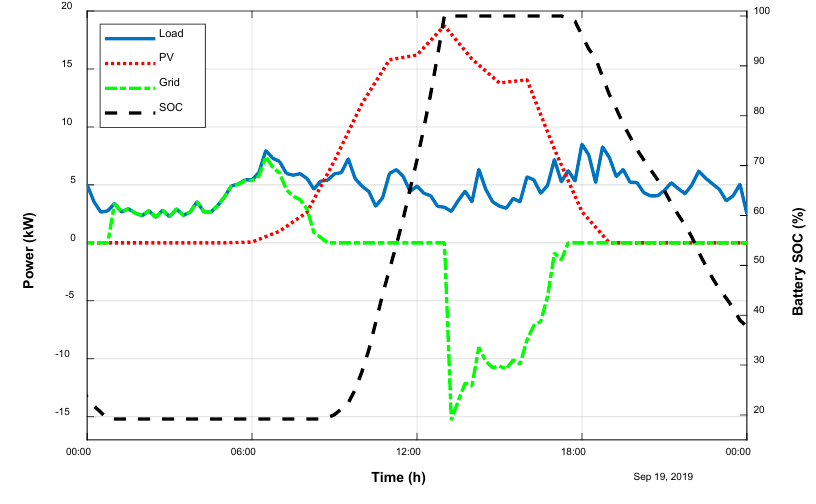
Figure 10. LFCS Figure 10. LFCS operation.